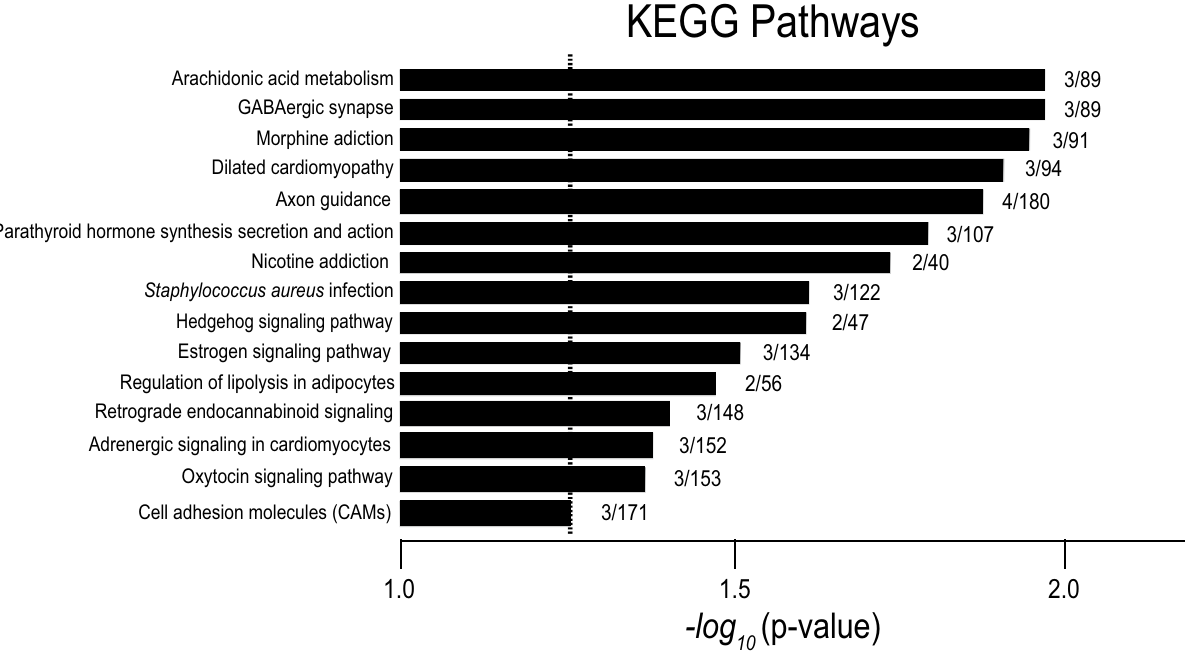
Figure 3 . Kyoto Encyclopedia of Genes and Genomes (KEGG) 4 pathways significantly enriched amongst differentially expressed genes. The X-axis represents the rank of KEGG terms based on statistical significance of the alterations of gene expression for genes in each category. Numbers beside bars are number of altered genes identified in the pathway/number of genes in that KEGG pathway total. Top 20 affected GO pathways are